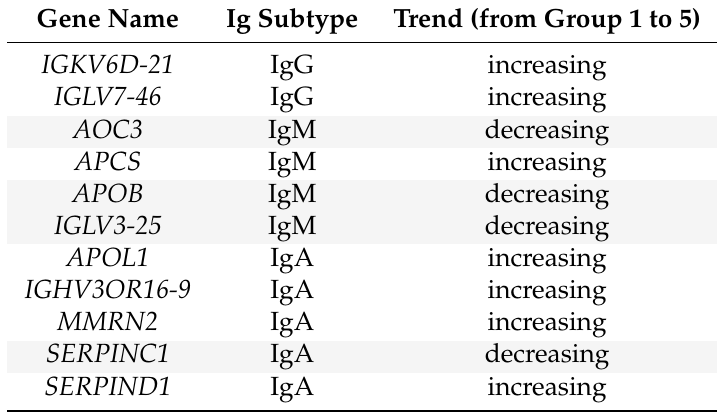
Table 2. List of significant Circulating Immune Complexes trends before